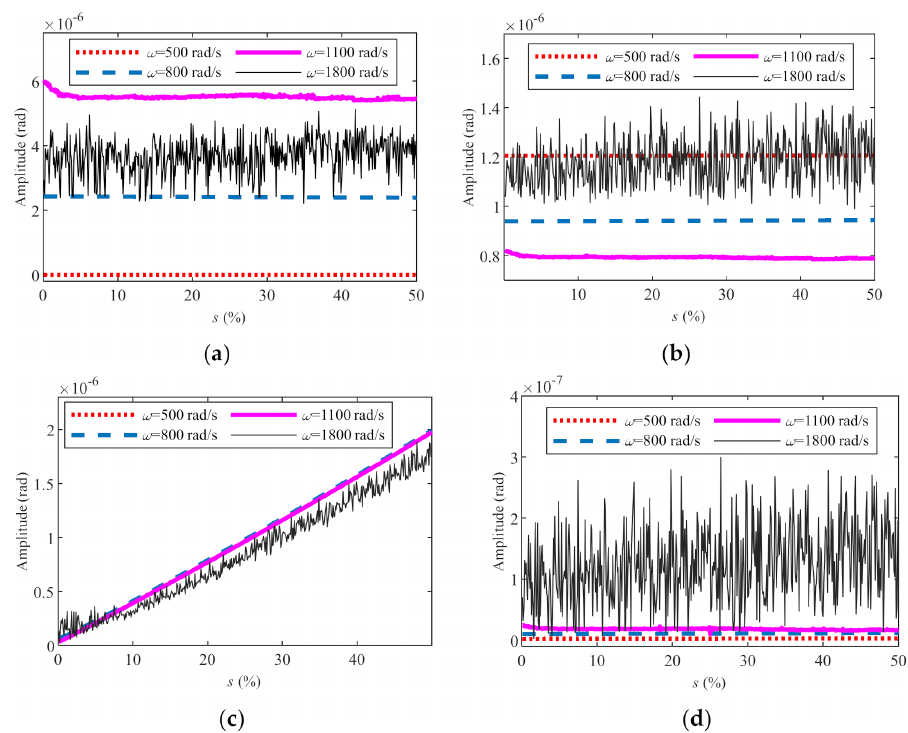
Figure 14. Spectrum amplitude varying with s at different speeds and frequencies: ( a ) Half the rotating frequency; ( b ) Rotating frequency; ( c ) Two times rotating frequency; ( d ) Three times rotating